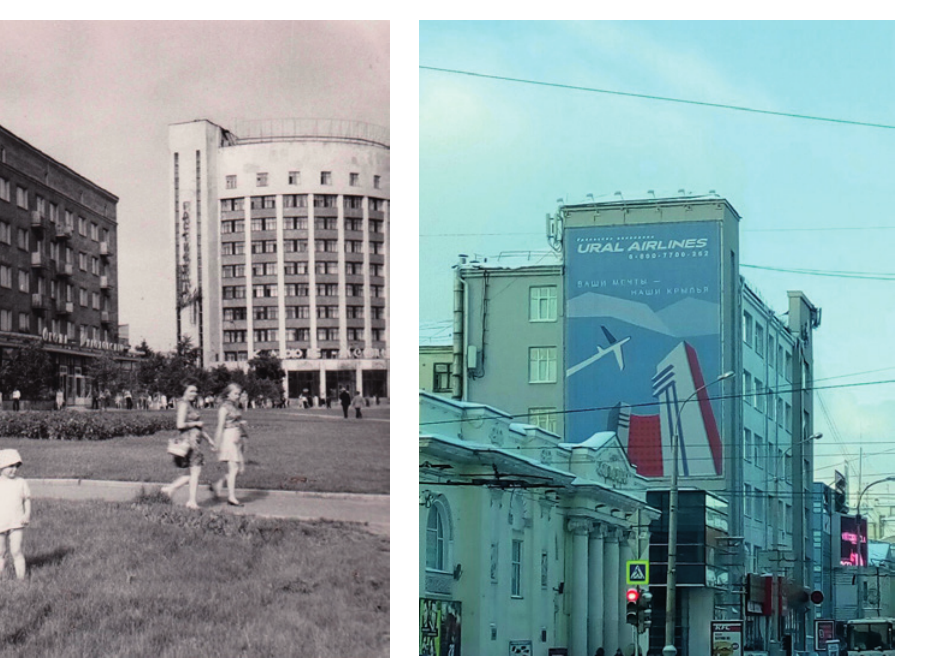
Figure 4. The advertising of the local airline Ural Figure 3. The Iset Hotel. Photo by Eduard Airlines with the picture of the Iset Hotel from the Starostov, 1972 from the personal archive of courtyard side. Photo by Liudmila Starostova, Liudmila Starostova